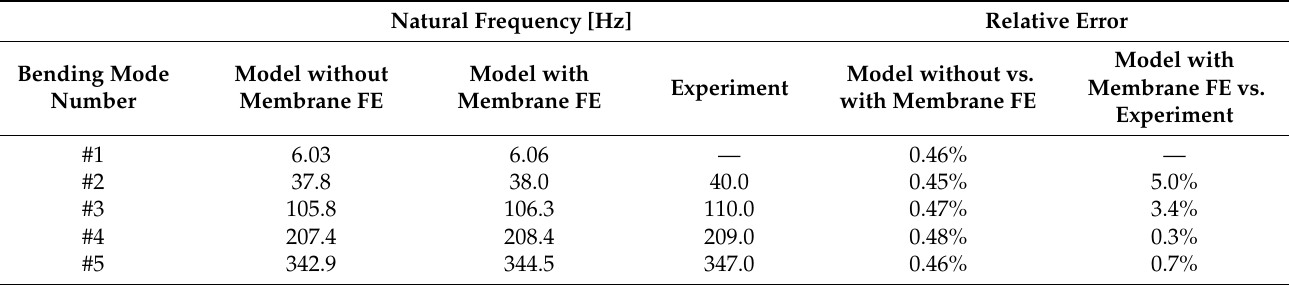
Table 2. Results of natural frequency comparison.